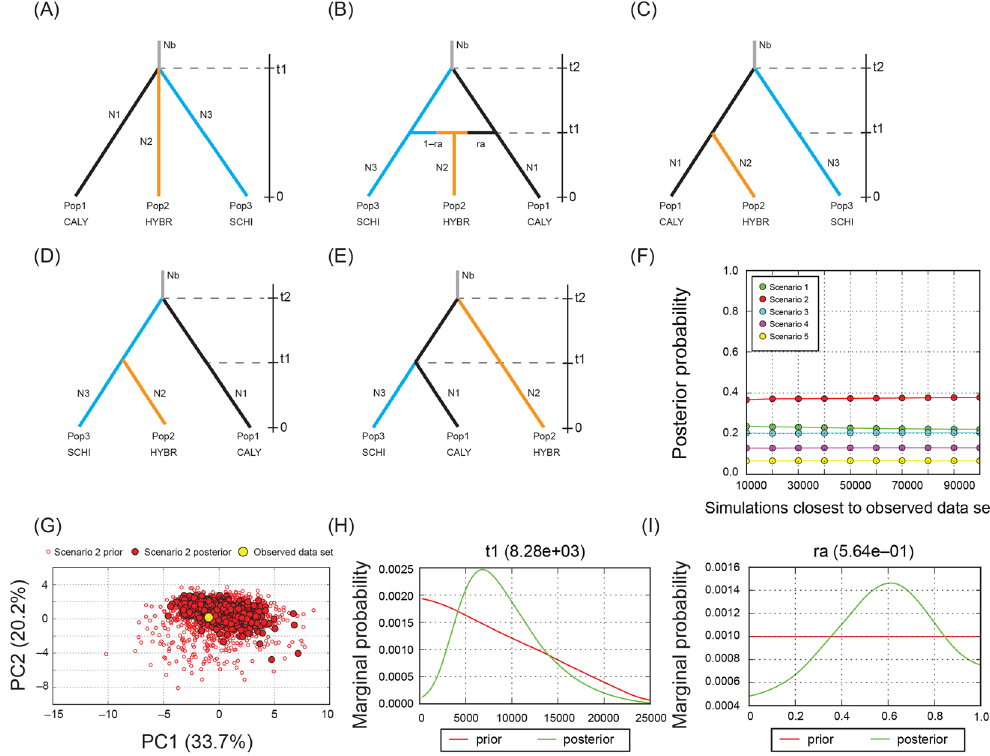
Figure 4. Competing demographic scenarios of Psittacanthus calyculatus divergence. Five evolutionary scenarios were built and tested using DIYABC: ( A ) simple split model (scenario 1), in which CALY (Pop1), HYBR (Pop2) and SCHI (Pop3) diverged simultaneously at t1; ( B ) isolation with admixture model (scenario 2), in which Pop2 (HYBR) was generated by admixture between Pops 1 (CALY) and 3 (SCHI) at t1, then CALY merged with SCHI at t2; ( C ) hierarchical split model 1 (scenario 3), in which HYBR merged with CALY at t1, then both populations merged with SCHI at t2; ( D ) hierarchical split model 2 (scenario 4), in which HYBR merged with SCHI at t1, then both populations merged with CALY at t2; ( E ) hierarchical split model 3 (scenario 5), in which CALY merged with SCHI at t1, then both populations merged with HYBR at t2. The posterior probability of scenarios was assessed using a weighted logistic regression on the 1% of simulated datasets closest to the observed data and, for the best-supported scenario (scenario 2); ( F ) Results of a logistical model comparing the posterior probability of each scenario with the number of simulations used to calculate it; ( G ) A model checking procedure was applied using a PCA on test statistic vectors to visualize the fit between the simulated and observed datasets. Note the large cloud of data from the prior and observed datasets centred on a small cluster from the posterior predictive distribution, suggesting that the best-supported scenario explained the observed data well. Prior and posterior probabilities of parameters t1 ( H ) and ra ( = admixture rate) are provided ( I